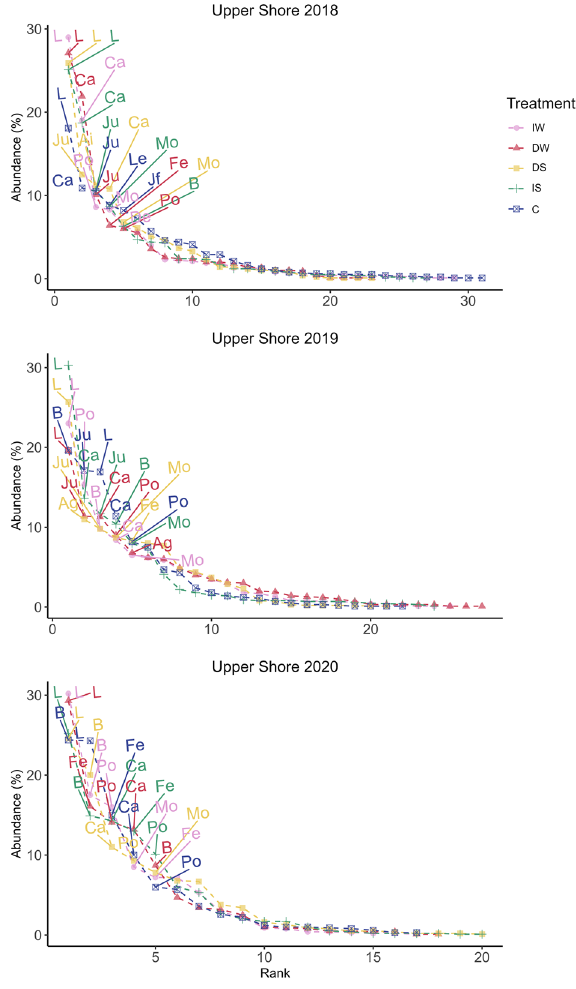
Figure 4. Rank abundance curve of the Upper Shore community. Mean abundance as percentage cover (n = 3) for August is on the y-axis, while species are ranked consecutively on the x-axis. Ca Carex nigra , Ju Juncus gerardii , Po Poa annua , B bare ground, Mo Molinea caerulea , Le Leontodon autumnalis , Ai Agrostis gigantea , De Deschampsia cespitosa , Ag Agrostis stolonifera , Fe Festuca rubra . Pink: increased water level (IW); red: decreased water level (DW); yellow: decreased salinity (DS); green: increased salinity (IS); blue: control